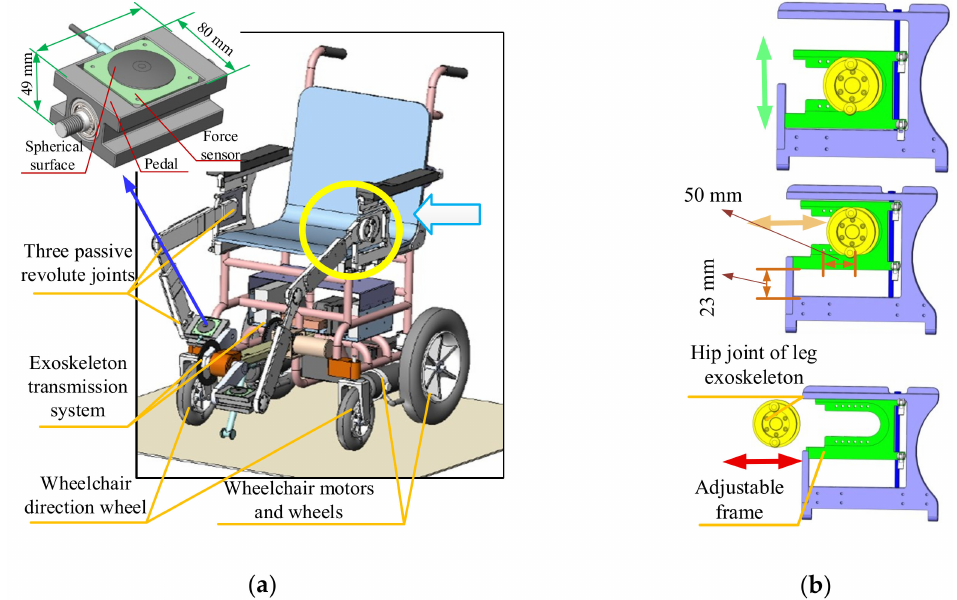
Figure 2. CAD design solution for novel leg-exoskeleton wheelchair robot: ( a ) Full mechanical design; ( b ) Hip joint adjusting